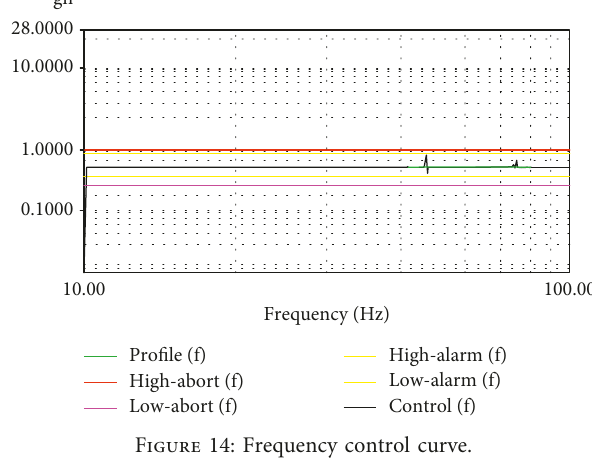
Figure 13: Fender forming margin diagram. Table 11: Information of 16 test points.